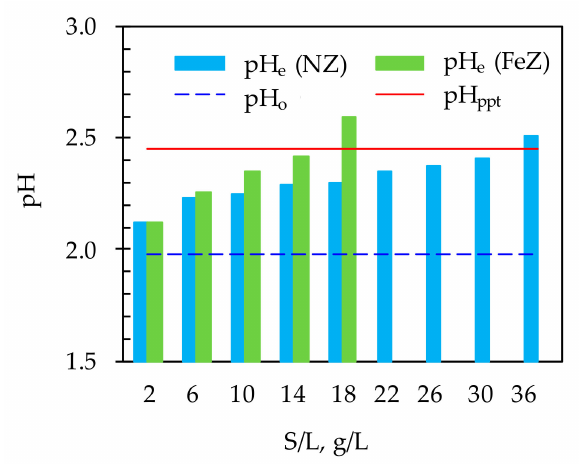
Figure 4. Comparison of pH e with pH ppt and pH o after the sorption of Hg(II) onto NZ and FeZ at di ff erent S / L